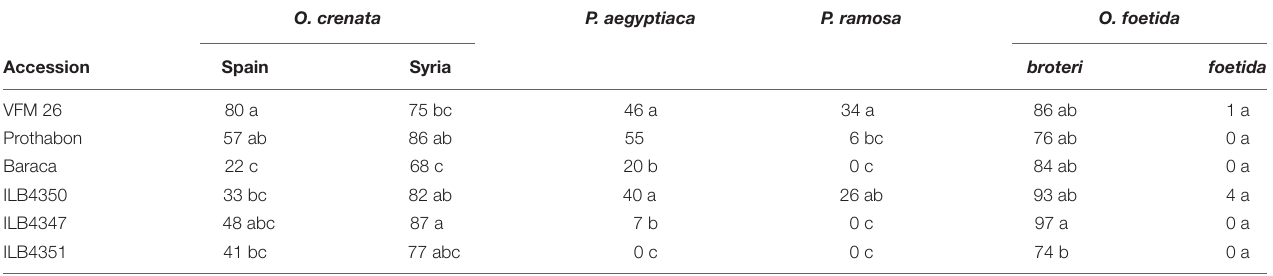
TABLE 6 | Percentage of germinated broomrape seeds that successfully established a tubercle on faba bean roots.